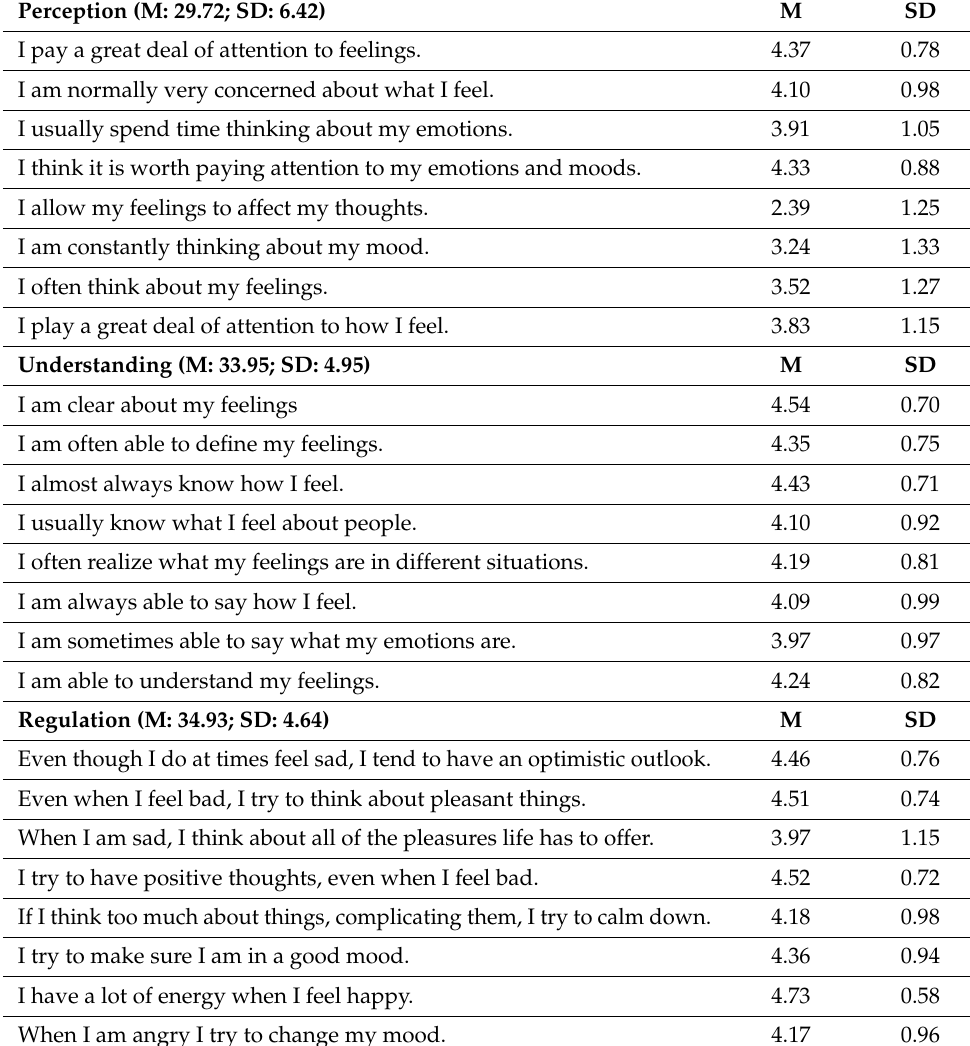
Table 3. Description of items by the factors that make up emotional